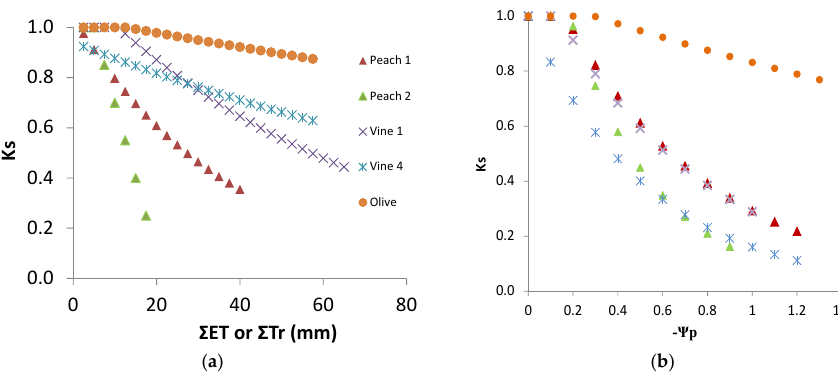
Figure 9. Simulated stress functions based on experimental data: ( a ) Ks in relation to Σ ET (similar to Σ Tr, in dry soil conditions; see the text), or SWD, for the five experimental situations selected, the two vines representing the extremes shown in Figure 7a; ( b ) Ks in relation to Ψ p . Symbols are the same in both figures.